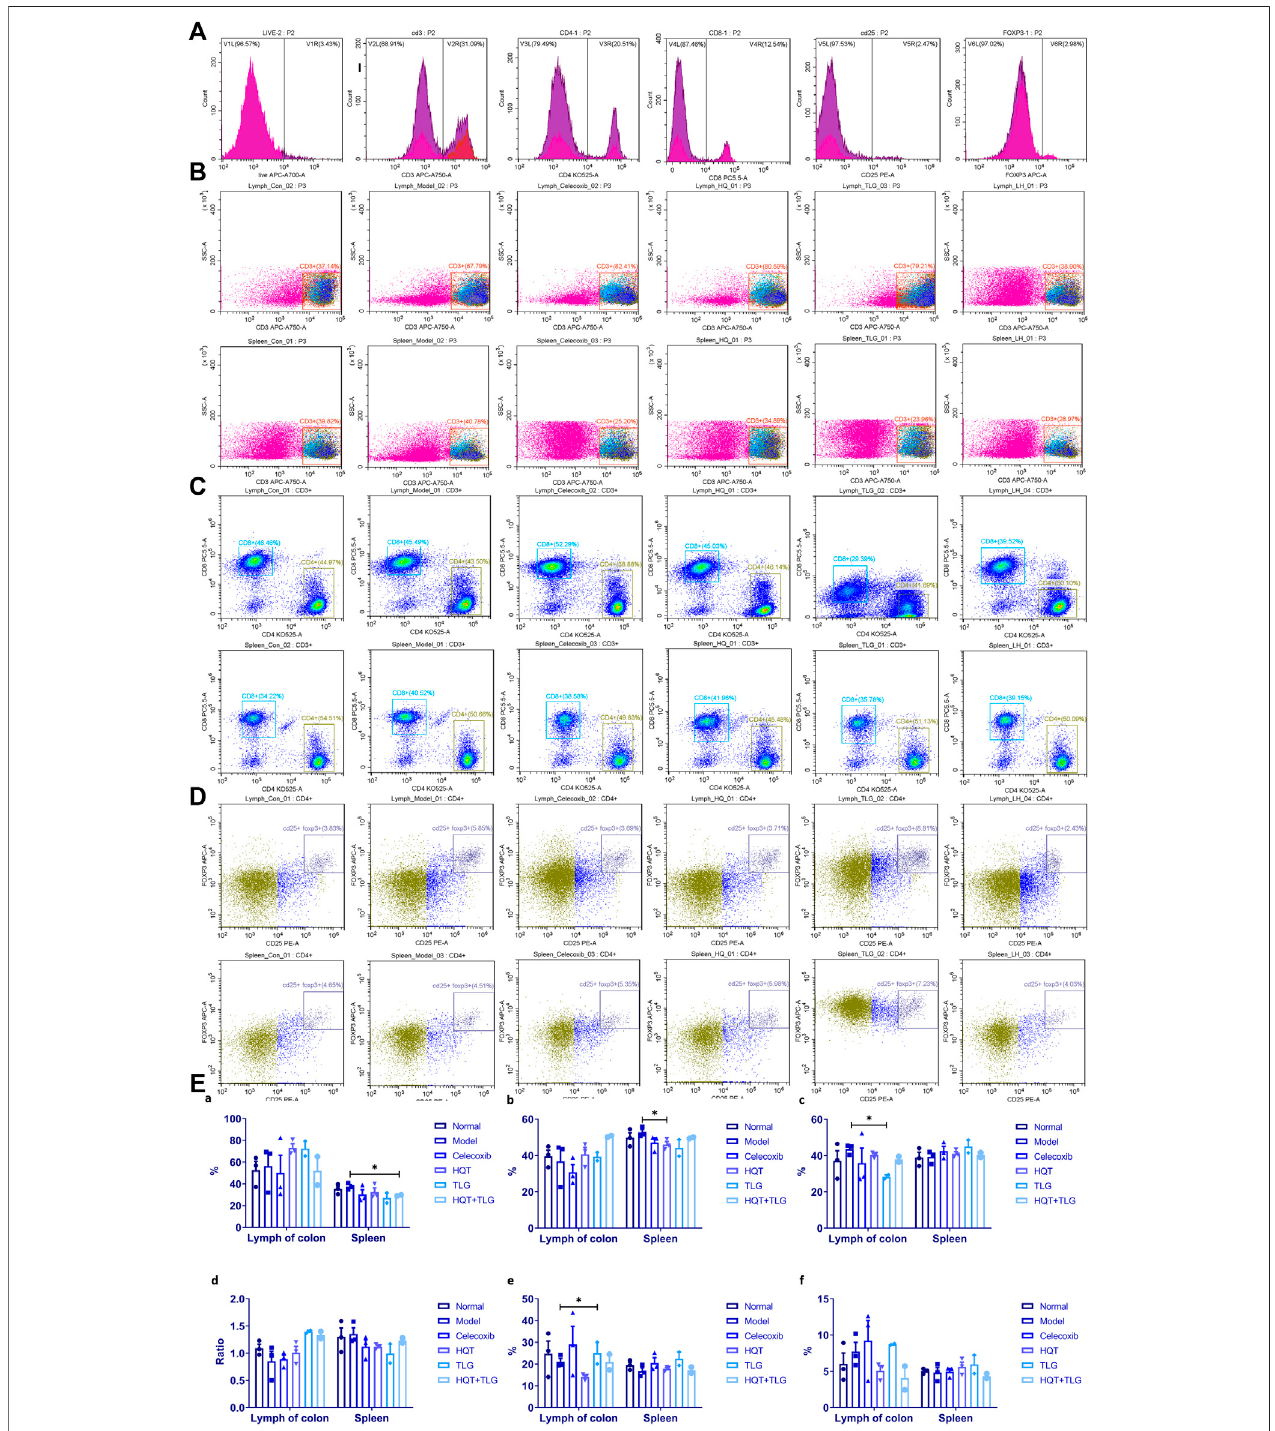
FIGURE 4 | Results of T-cell analysis in colon tissue and spleen. (A) Single-tube staining. (B) Composition of T cells in intestinal lymph nodes. (C) Composition of T cells in spleen. (D) Composition of CD25 + FOXP3 + T cells in intestinal lymph nodes. (E) Statistics of T-cell classi fi cation. Compared with the model control group, * p <